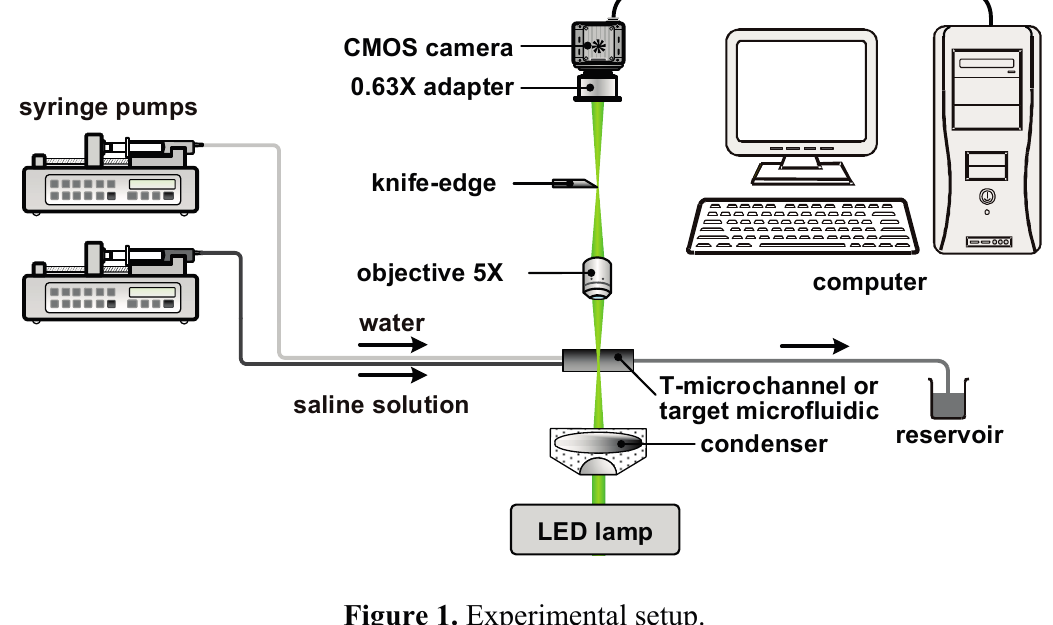
Figure 1. Experimental